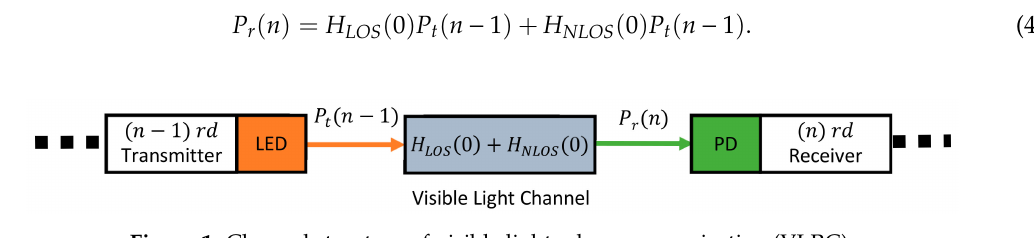
Figure 1. Channel structure of visible light relay communication